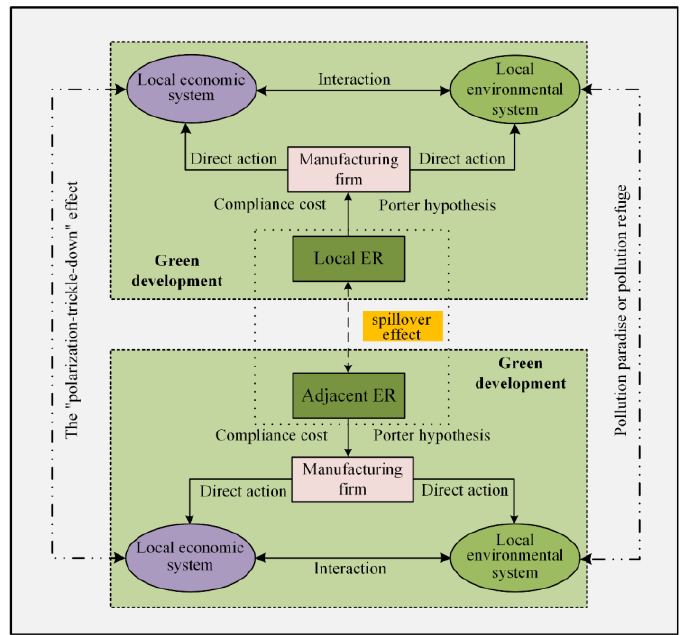
Figure 1. Theoretical framework.